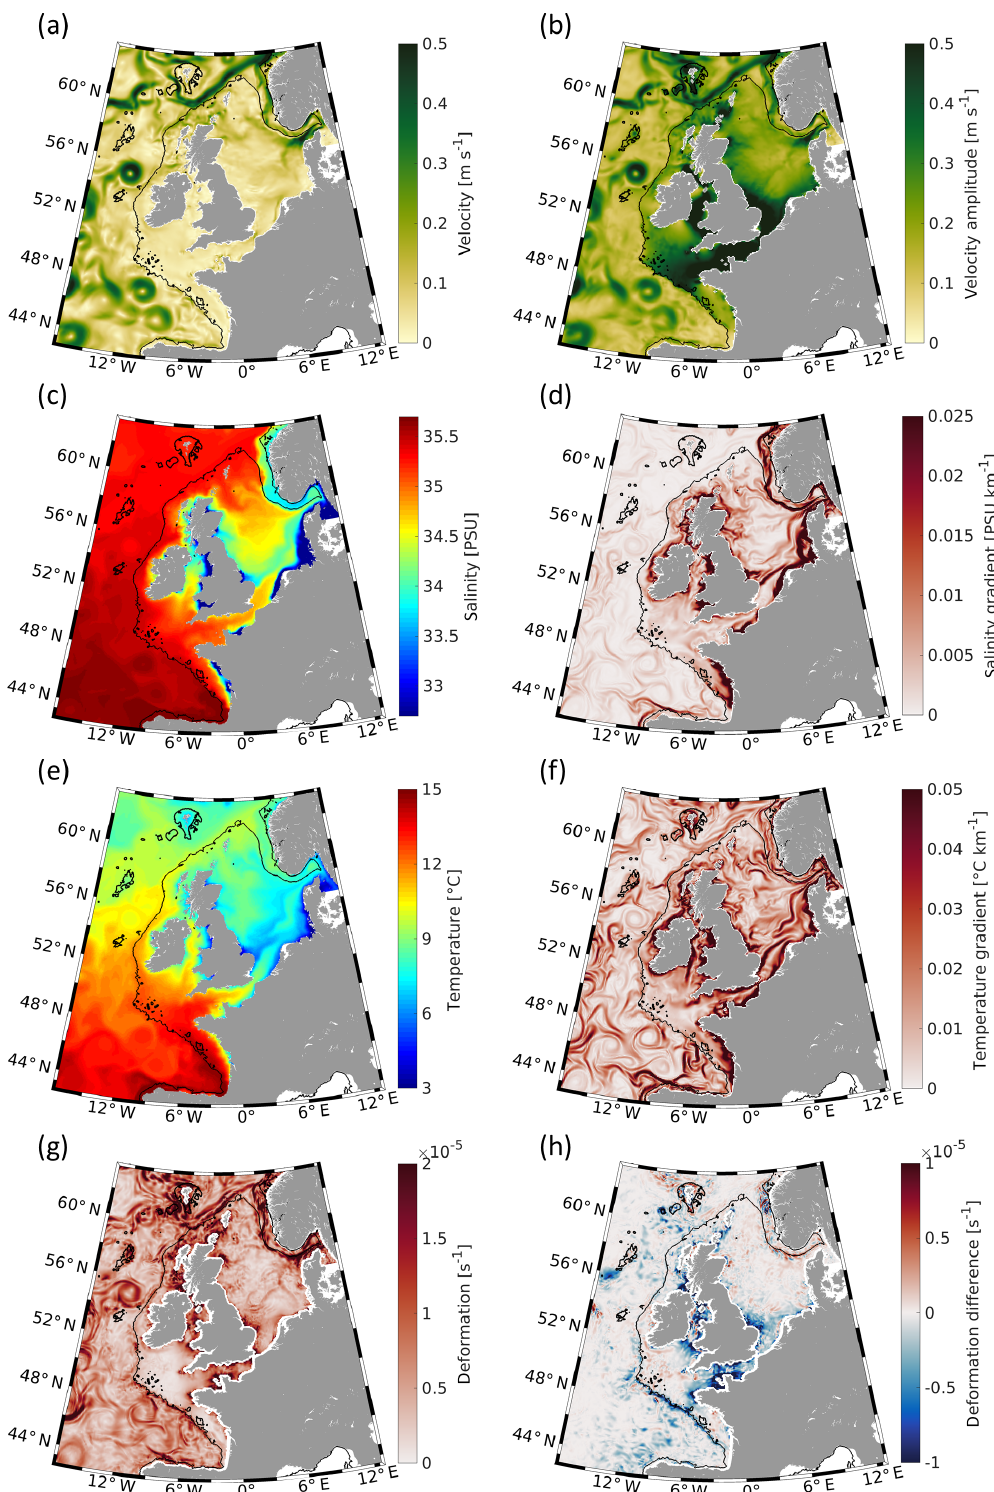
Figure 2. Simulated surface properties in the control run (CR, no. 1; see Table 1) for January 2015: (a) velocity magnitude derived from the averaged u and v velocity components, (b) mean velocity magnitude, (c) mean salinity, and (e) mean temperature. Magnitudes of the (d) temperature and (f) salinity gradients as well as (g) the deformation in the CR and (h) the differences of the non-tidal experiment (NTE, no. 2) minus CR of the deformation are presented as 24.84h averaged fields on 15 January